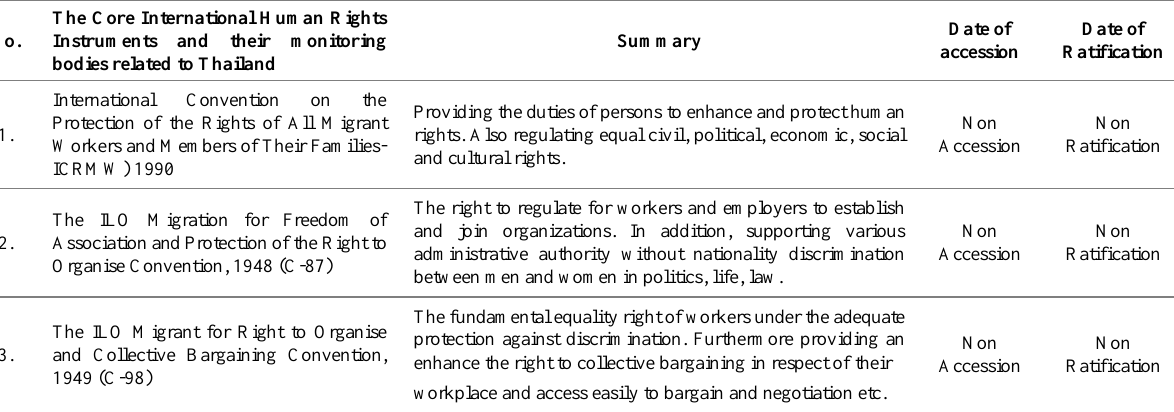
Table 1. Conventions Related to Foreign Workers in